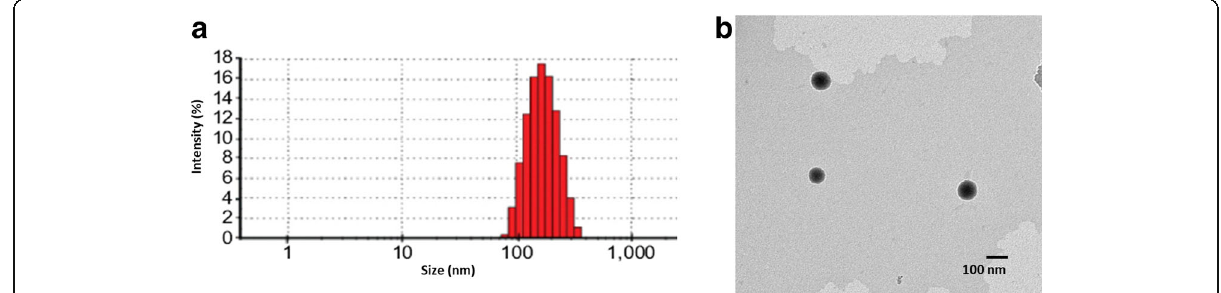
Fig. 2 a Particle size distribution of TPLN measured by dynamic light scattering (DLS) analysis. b Particle shape measurement by